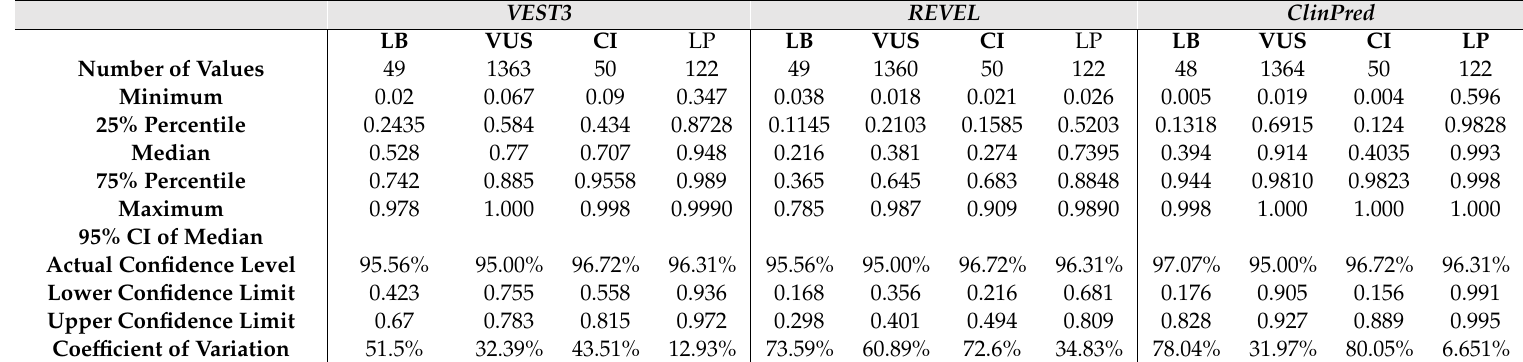
Table 1. Descriptive statistics of ClinVar NF1 variants prediction scores by VEST3, REVEL,